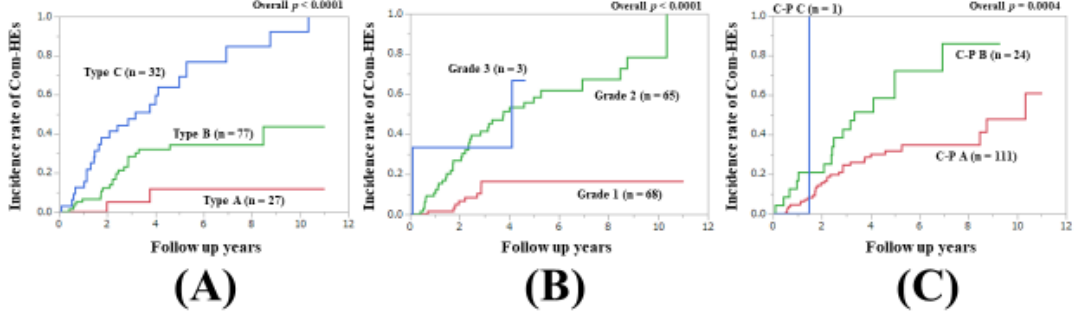
Figure 7. Cumulative incidence rates of composite hepatic events in patients with BMI < 22.7 kg / m 2 (median value in our cohort, n = 136). ( A ) Serum Zn level grading system. ( B ) ALBI grading system. ( C ) Child–Pugh classification.